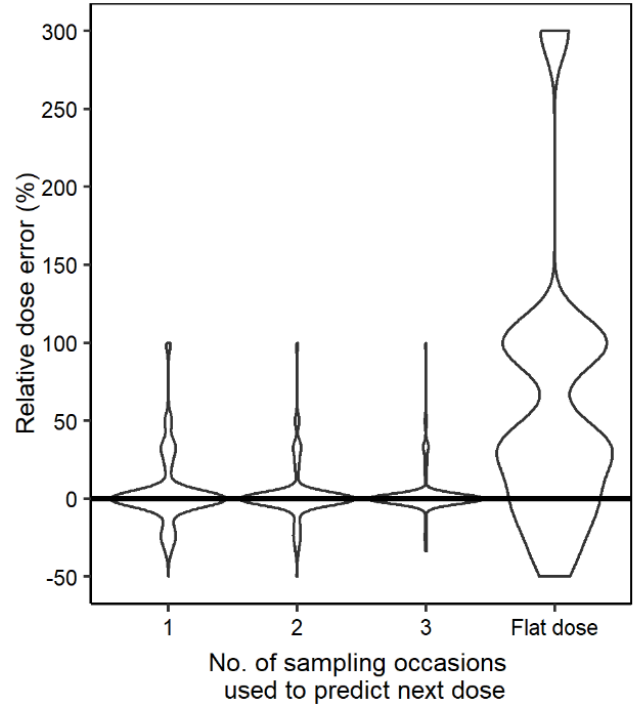
Figure 5. Violin plot showing the dose prediction error comparing the true dose to the individualized dose derived based on information from one, two, and three sampling occasions, as well as flat dosing of 600 mg QD for comparison.